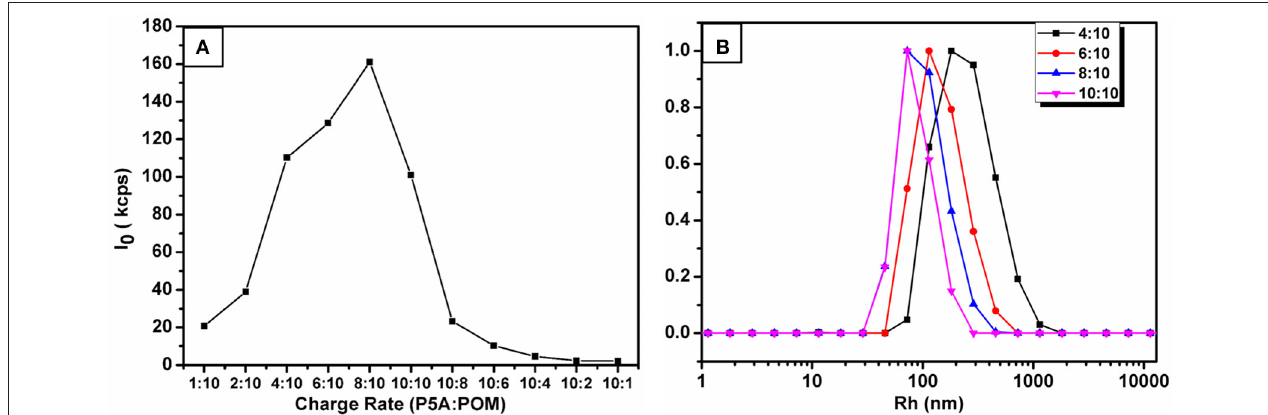
FIGURE 2 | (A) DLS total scattered intensity I of the P5A-CrMo 6 complex at different charge ratios. From left to right, the charge rate of P5A:CrMo 6 is 1:10, 2:10, 4:10, 6:10, 8:10, 10:10, 10:8, 10:6, 10:4, 10:2, 10:1. The concentration of (P5A-CrMo 6 ) was controlled at 0.05 mg/mL. (B) The size distribution at different charge ratios obtained by a CONTIN analysis with normalized counts by DLS.